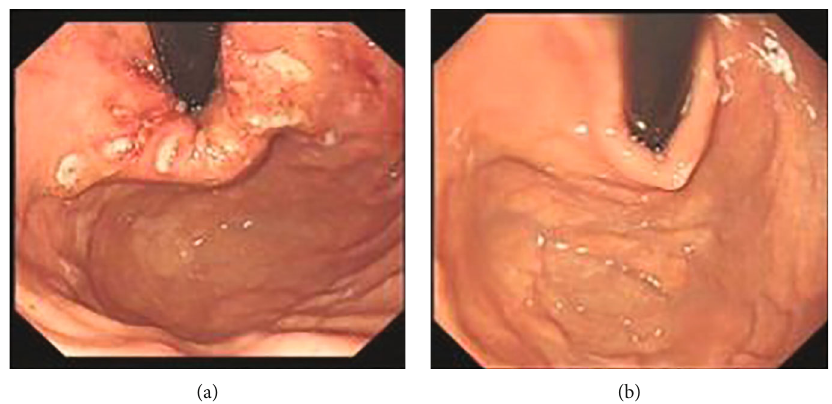
Figure 3: Endoscopic image immediately (a) and 12 months (b) after the procedure. Table 1: Baseline